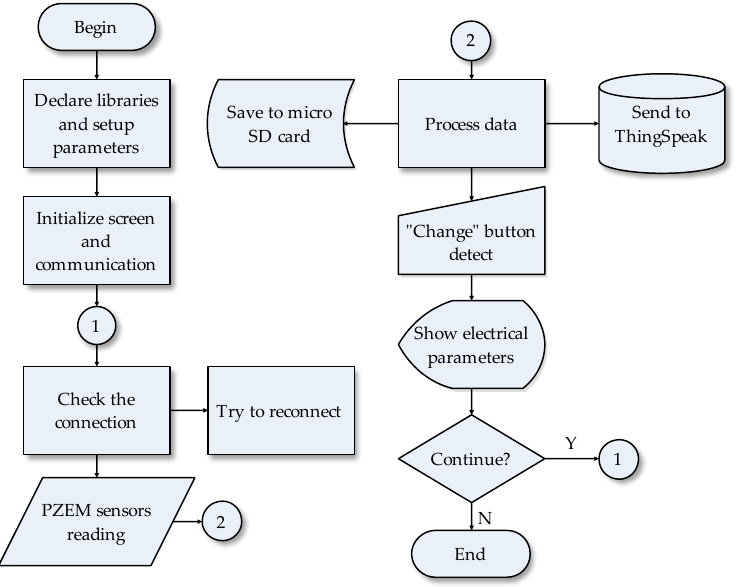
Figure 6. Main program flow chart for M5Stack Core2.